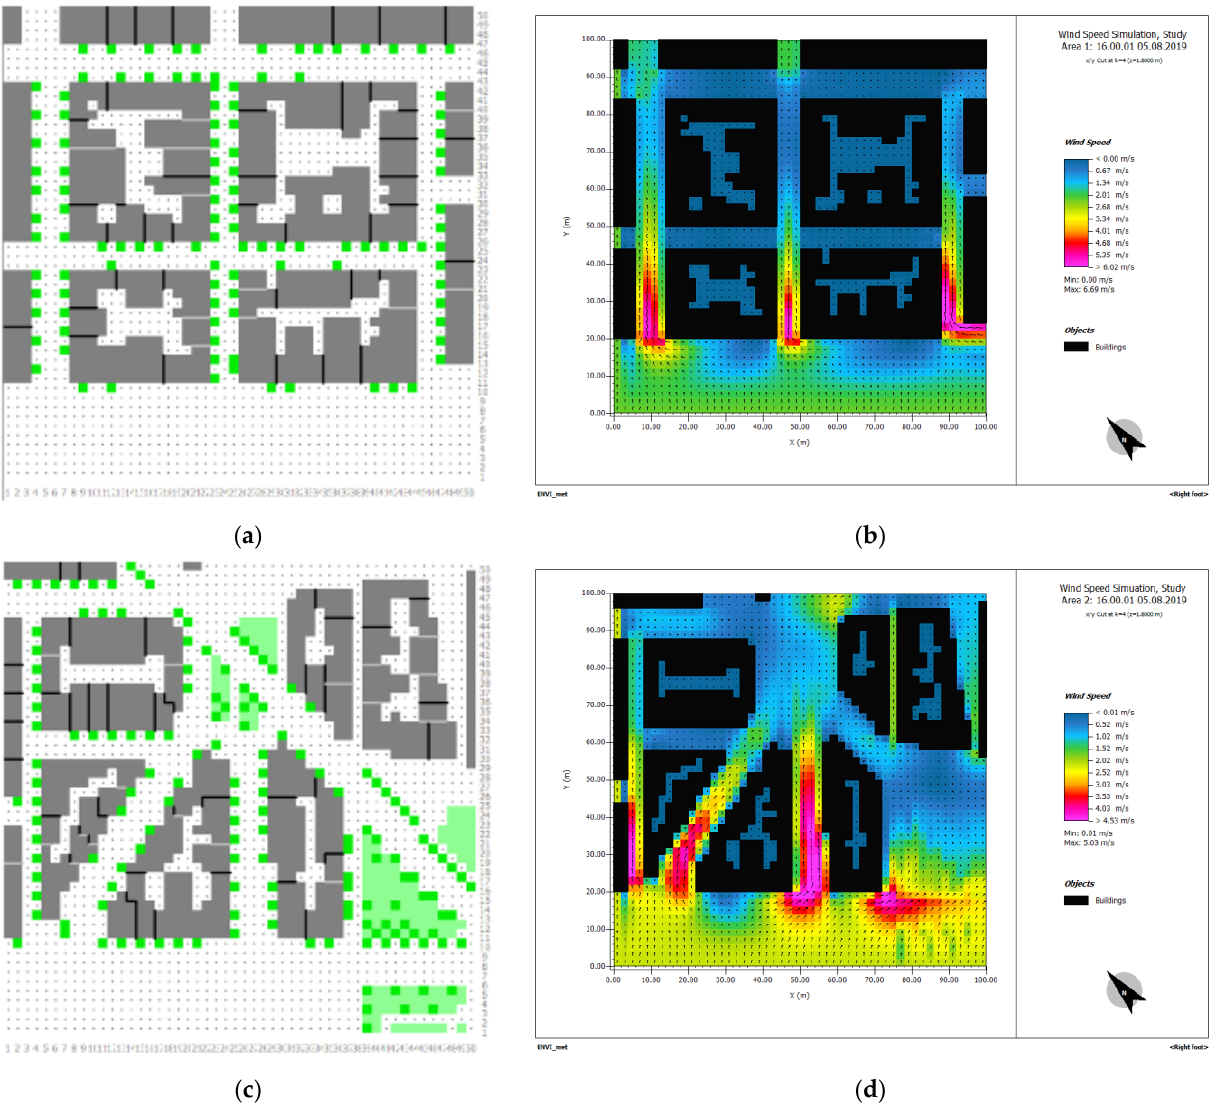
Figure 11. ( a ) Two-dimensional display of the first section where the buildings are shown in gray and the positions of the tree planting in green; ( b ) Wind speed simulation for the first section of the study area; ( c ) Two-dimensional display of the second section where the buildings are shown in gray and the positions of the tree planting in green; ( d ) Wind speed simulation for the second section of the study area, ENVI-met© software.